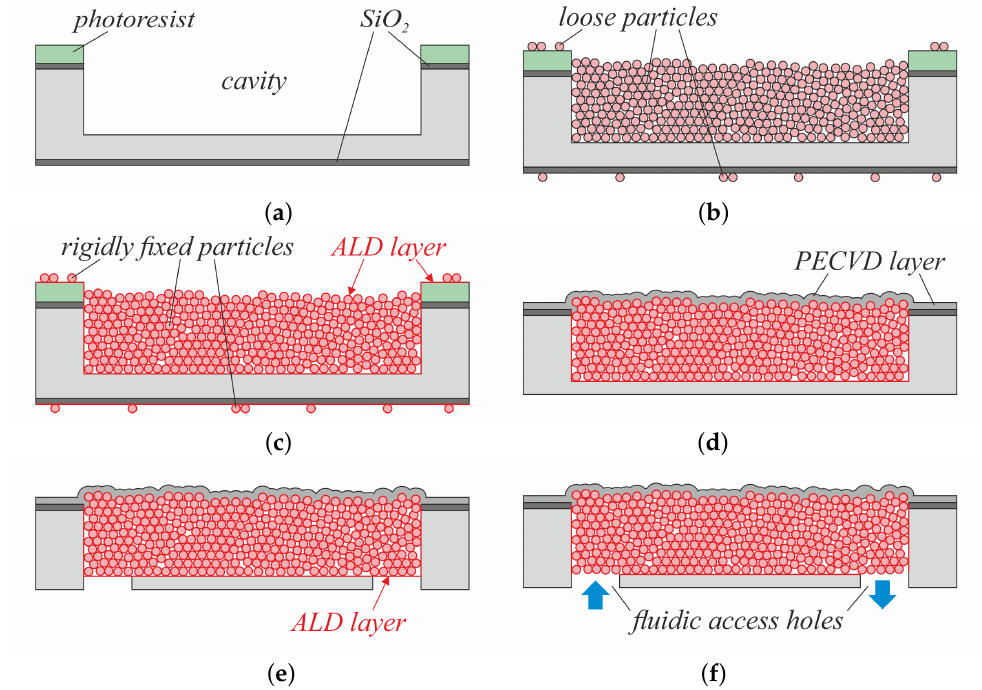
Figure 1. Schematic illustrations ( a – f ) of the fabrication process of test structures with soft magnetic flow-through cores on Si